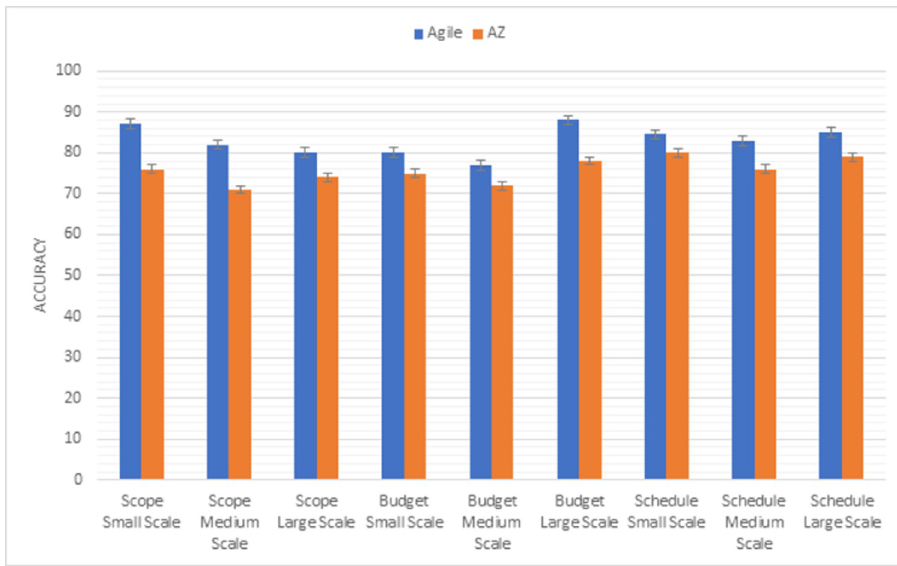
Fig 5. Graphical representation of agile vs AZ (first triangle)